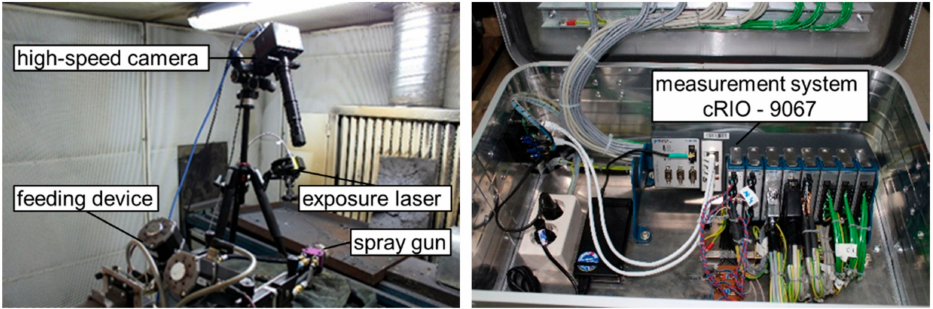
Figure 1. Experimental setup for determining particle detachment, ( left ): high-speed camera, ( right ): NI cRIO measurement